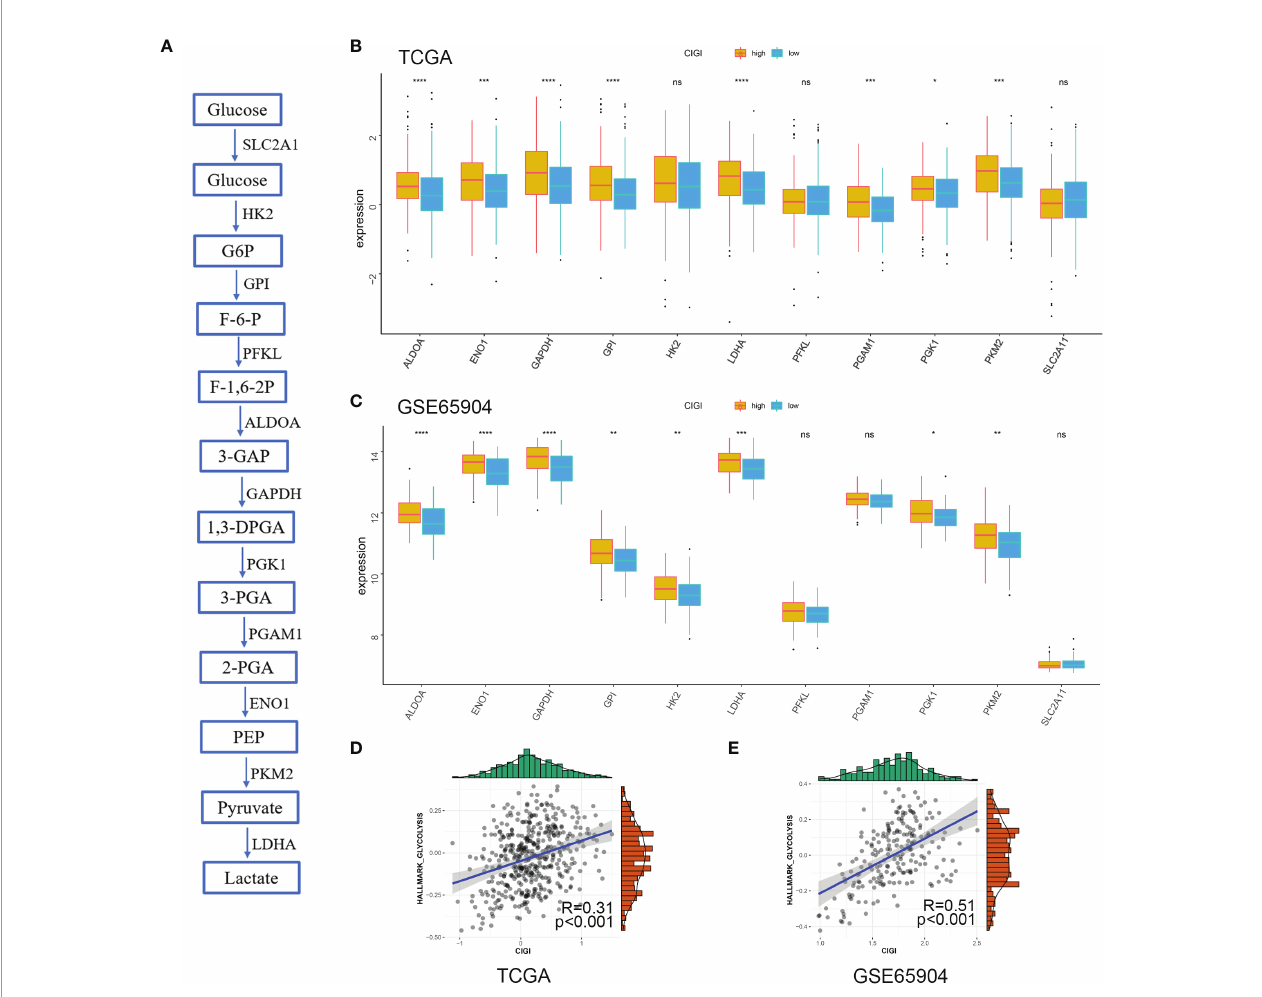
FIGURE 7 | Glycolysis Pro fi le in CIGI. (A) Summary of the glycolytic genes. (B) Expressions of glycolytic genes between the high- versus low-CIGI group in the TCGA dataset. (C) Expressions of glycolytic genes between the high- versus low-CIGI group in the GSE65904 dataset. (D, E) Correlations of ssGSEA scores of “ HALLMARK GLYCOLYSIS ” pathway with CIGI in the TCGA (R = 0.31, p < 0.001) and GSE65904 (R=0.51, p < 0.001) datasets. *p < 0.05, **p < 0.01, ***p < 0.001, ****p < 0.0001. ns, no signi fi